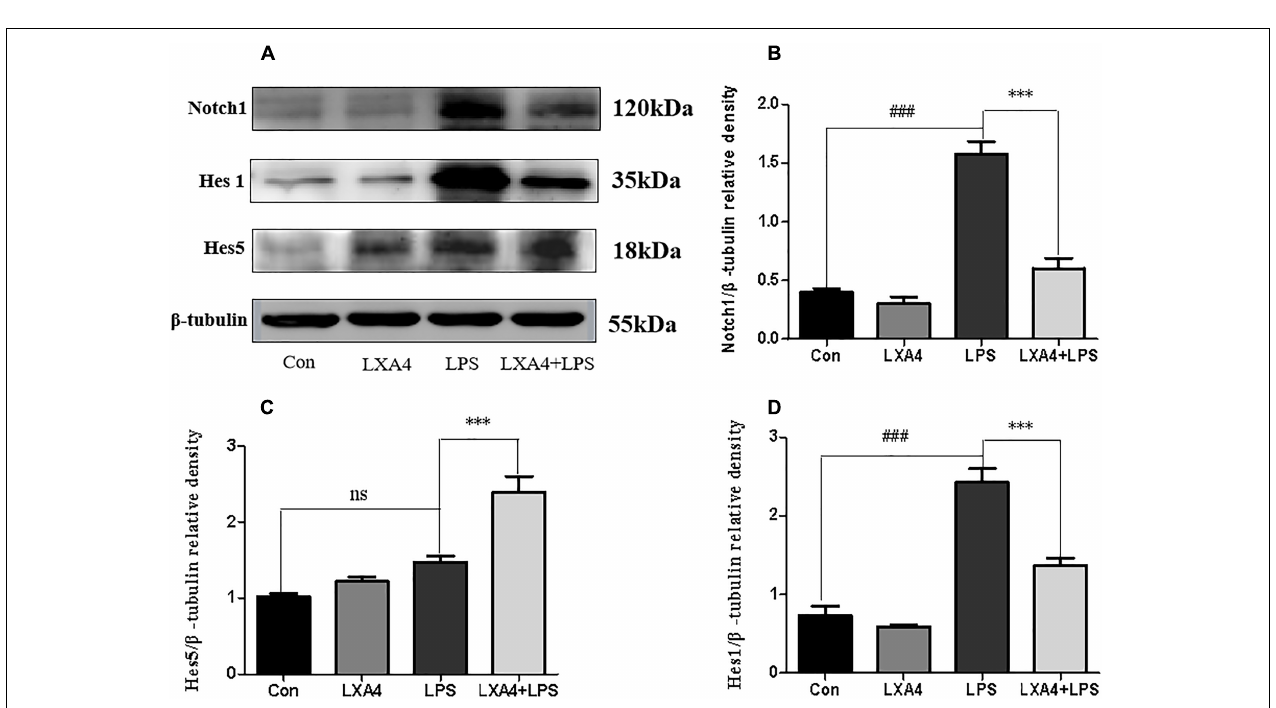
FIGURE 10 | Western blot analysis of the effect of LXA4 on Notch1, Hes1 and Hes5. (A,B,D) Western blot analysis of the protein level of Notch1, Hes1 in microglia. (A,C) Western blot analysis of the protein level of Hes5 in microglia, LPS upregluated M1 microglia related signal molecule Notch1, Hes1. With LXA4 intervention, Notch1, Hes1 expression decreased, M2 microglia related signal molecule Hes5 expression increased significantly. ### , ∗∗∗ p < 0.001; n.s., no